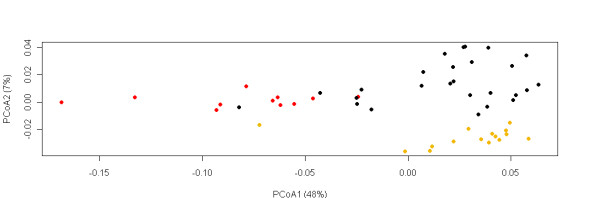
Principal coordinate plot of breeds based on Chord distance. Axis I explains 48% of the variation, axis II explains 7% of the variation. Breeds from Nordic cluster (based on STRUCTURE) are marked with red, breeds from Fat-tailed cluster are marker with yellow and breeds from the Composite cluster are marked with black circles.